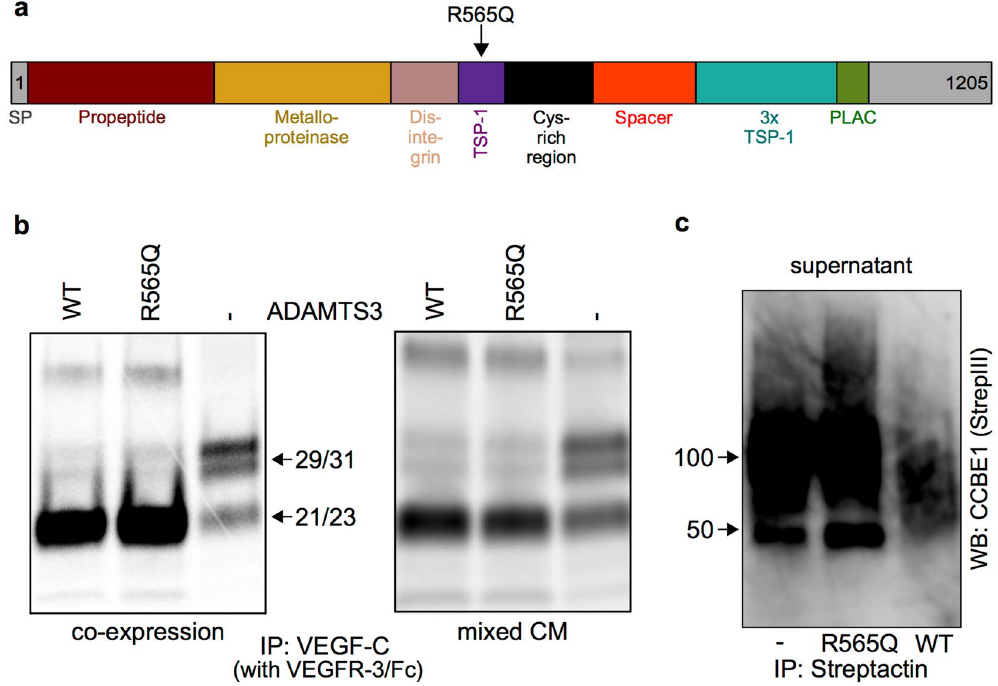
Figure 6. The R565Q substitution in ADAMTS3 interferes with the interaction of ADAMTS3 with CCBE1. ( a ) Schematic domain structure of ADAMTS3 (Uniprot) and location of the R565Q substitution. TSP-1: Thrombospondin 1; PLAC: Protease and lacunin. ( b ) The ADAMTS3 R565Q variant activates pro-VEGF-C equally well as wild type ADAMTS3 both when co-expressed in 293 T cells with VEGF-C (left) and when conditioned media (CM) from individually transfected 293 T cells were mixed (right). ( c ) Higher amounts of CCBE1 are present in the conditioned medium of ADAMTS3-R565Q variant or mock-transfected cells compared to the conditioned medium of cells transfected with wild type ADAMTS3. CCBE1 protein is secreted as a core protein of approximately 45–50 kDa and as a diffuse, chondroitinylated band around 100 kDa 11, 16 . The full length blots are shown in Supplementary Fig.